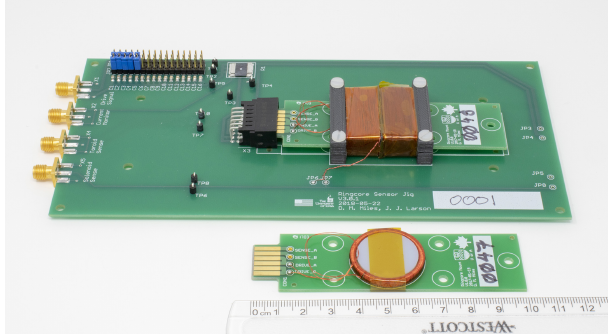
Figure 16. Test jig used to rapidly characterize multiple ring cores. Each ring core has a toroidal drive winding applied and is mounted on a small printed circuit board. The mounted ring core inserts through a modified sense winding and the entire assembly is placed in a solenoid–magnetic shield for testing.